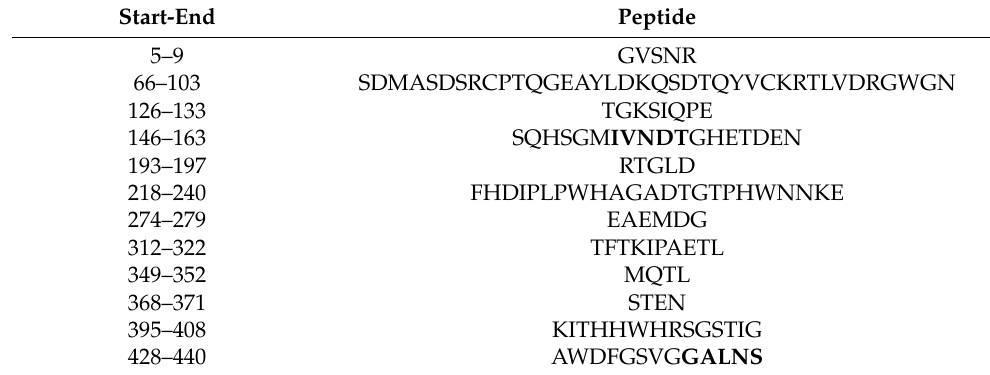
Table 2. Antibody epitope prediction for epidemical ZIKV (BEH819015) envelope protein. Summary of all antibody predicted epitope using IEDB tools with ZIKV (BEH819015) envelope protein as query. In bold are highlighted the sequences with substitutions in BEH819015 strain compared with MR766-NIID